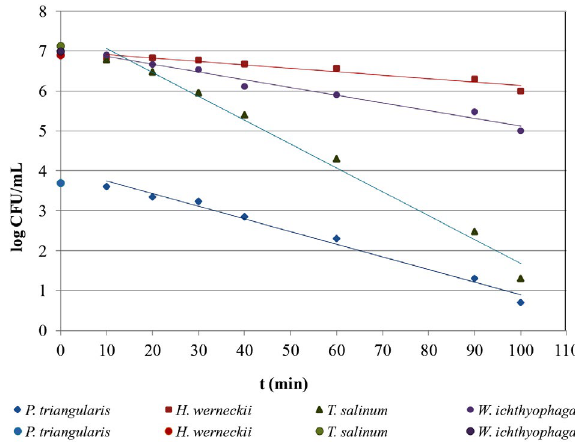
Figure 1: Survivor lines for H. werneckii , P. triangularis, T. salinum, and W. ichthyophaga after homogenization of cell suspension at 35 °C in relation to homogenization time. Experiments were repeated three times. Coefficients of determination (R 2 ) for linear regression are 0.985 (for P. triangularis ); 0.942 (for H. werneckii ); 0.987 (for T. salinum ); and 0.974 (for W. ichthyophaga